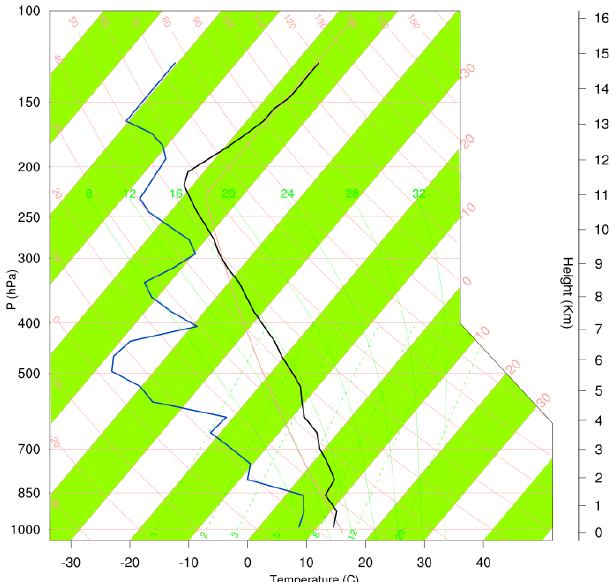
Fig. 4. The initialization vertical dry bulb (black) and dewpoint tem- perature (blue) skew-T profiles at the model coastline originally ob- served at Herstmonceux station at 00:00UTC on 4 June 2006.